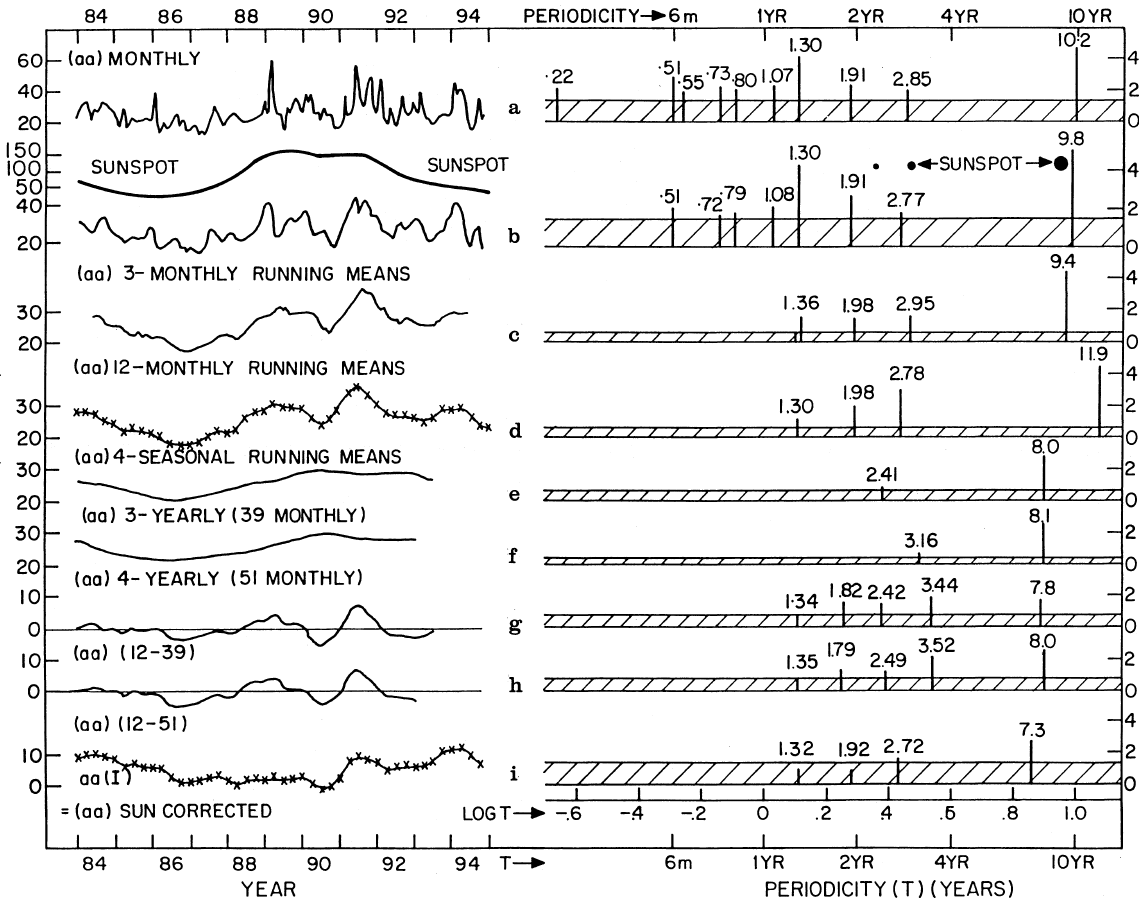
Fig. 1a–i. Left half, plots of aa indices; right half , spectra. a Monthly means of aa index; b 3-monthly running means of aa and the smoothed sunspot numbers ( thick line ); c 12-monthly running means; d 4 seasonal running means (4 values per year); e 3-yearly (39 months)